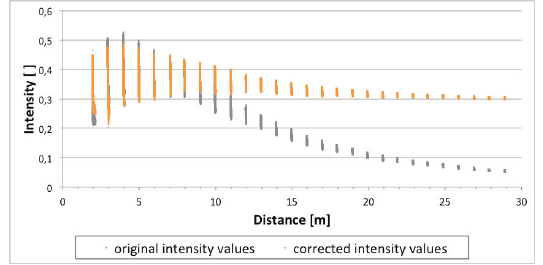
Figure 14. Correction of raw intensity values of the standard target (Z+F,